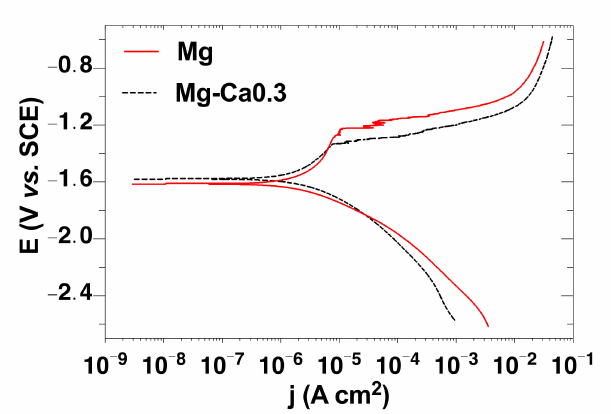
Figure 6. Potentiodynamic polarization (PDP) curves of Mg and Mg-Ca0.3 after 24 h of immersion in Hank’s solution.